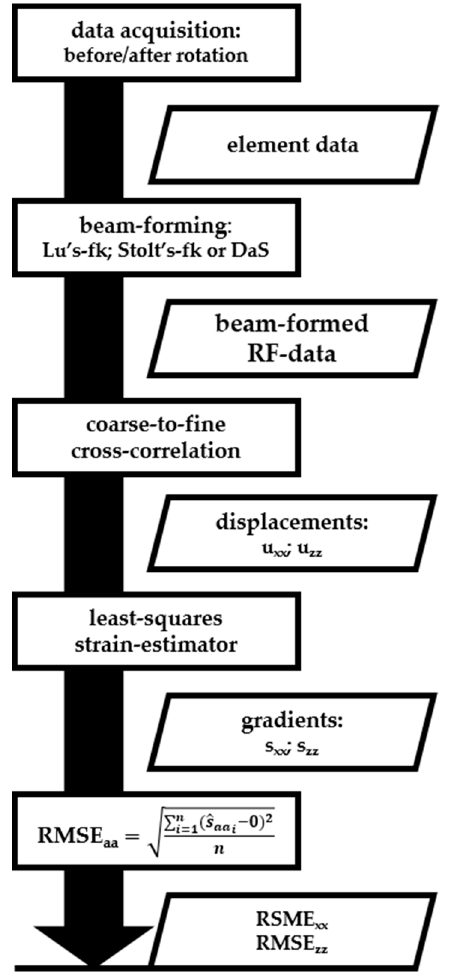
Figure 5. Summary of the processing flow described in the Material and Methods section. This work flow was repeated for every transducer (Table 1). Rectangles represent processing steps (acquisitions or calculations) and parallelograms represent (intermediate) results.